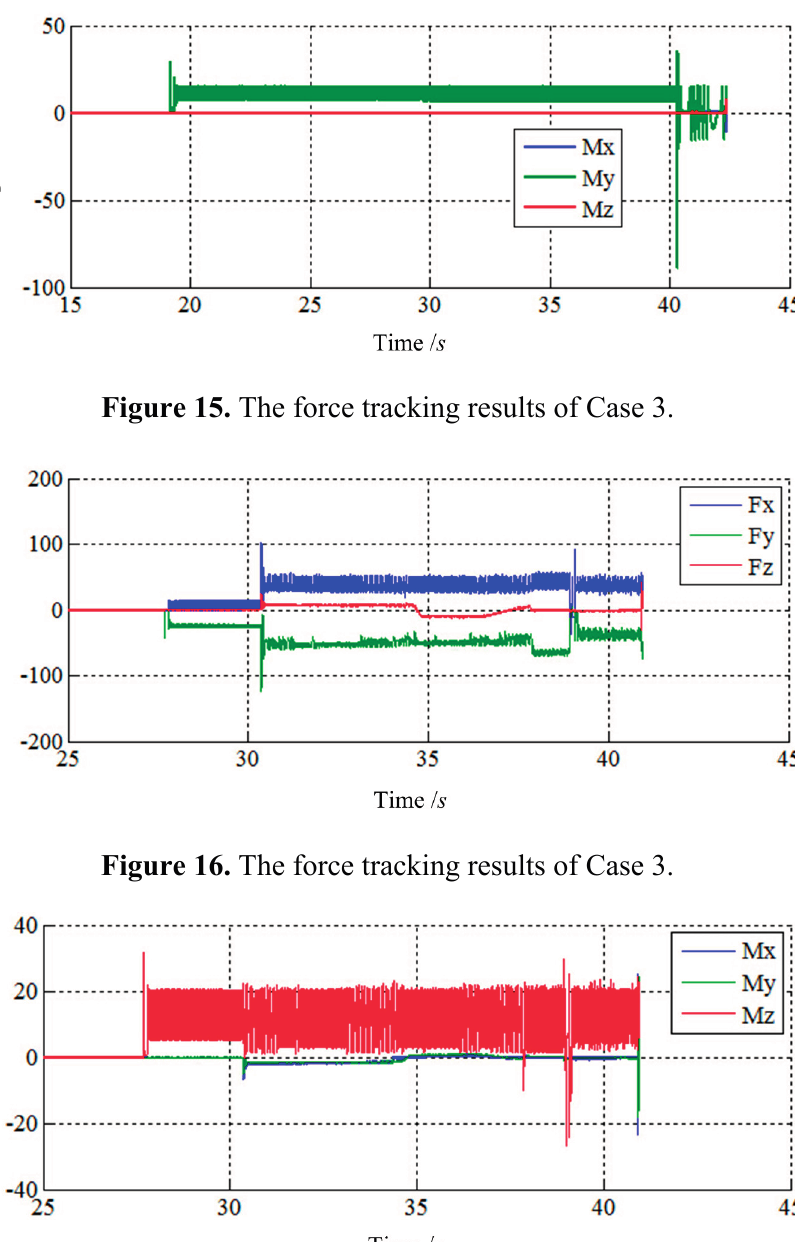
Figure 14. The torque tracking results of Case 2.